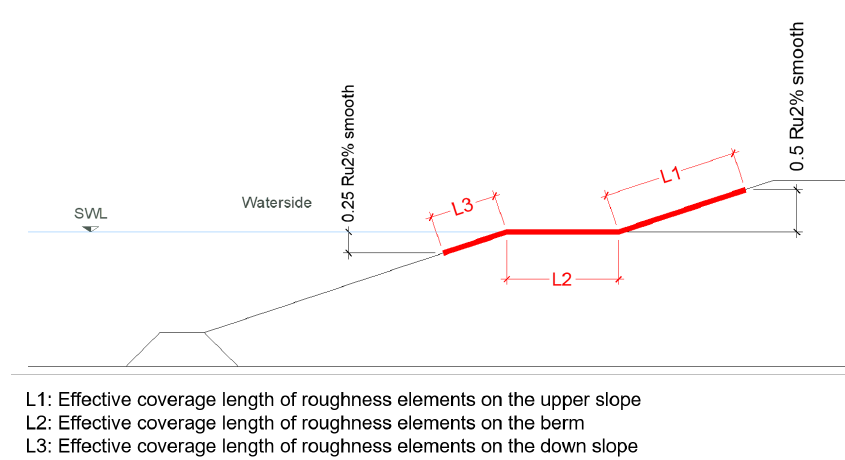
Figure 2. Coverage lengths of roughness elements applied along the waterside